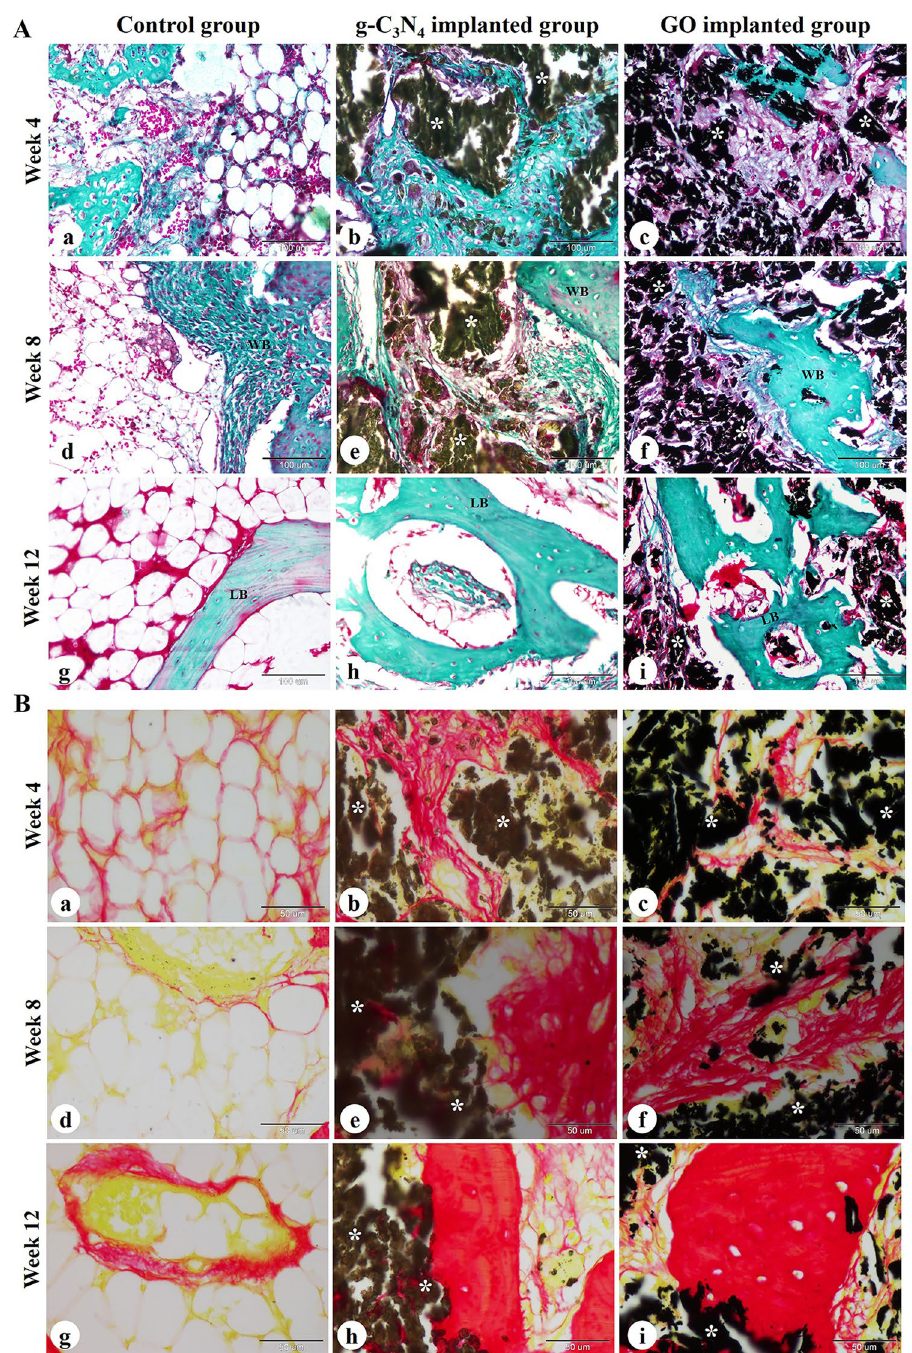
Figure 5. Histochemical evaluation of femoral condyle defect in rabbits. The repair site of the femoral condyle at weeks 4, 8, and 12 after surgery in control (a, d, g), g-C 3 N 4 implanted (b, e, h), and GO implanted groups (c, f, i) was stained with Crossmon’s trichrome ( A ) and Sirius red ( B ) stains. WB woven bone, LB lamellar bone; white asterisks: implanted nanomaterial. The scale bars in Crossmon’s trichrome stain panels = 100 μm, Sirius red stain panels = 50